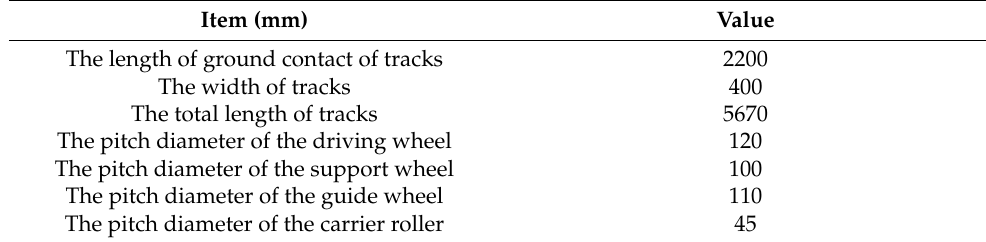
Table 3. Main parameters of the crawler devices.